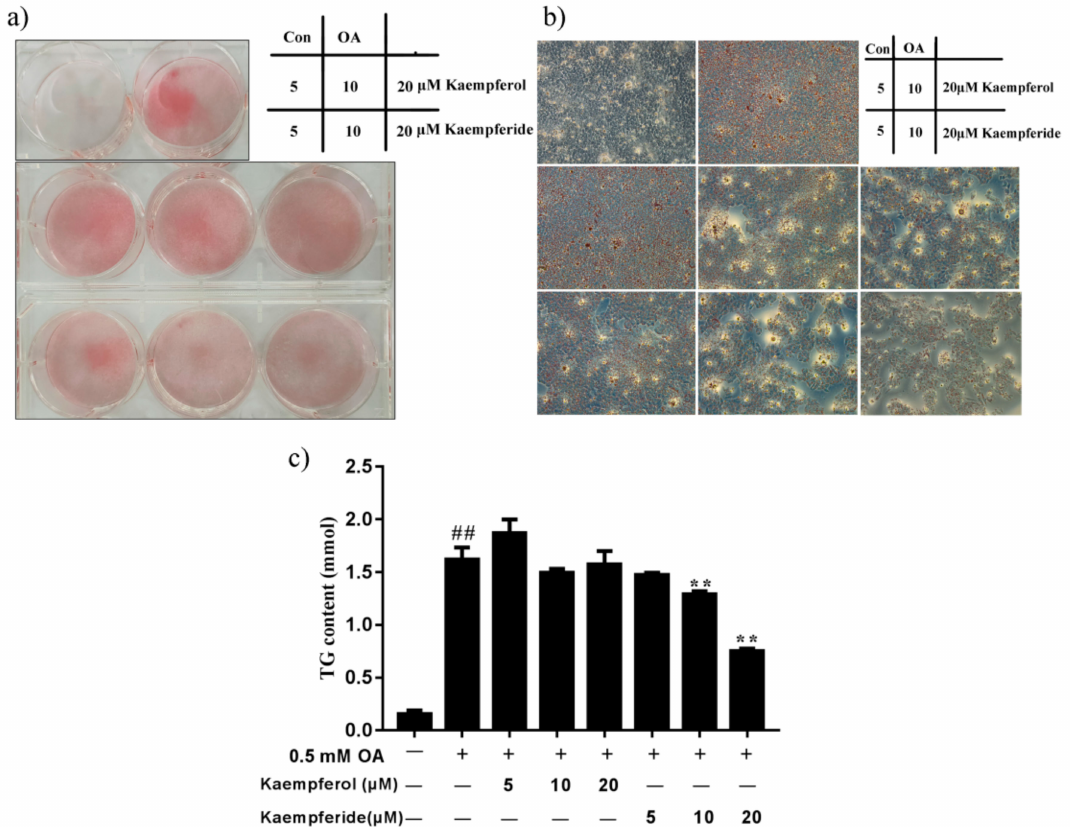
Figure 4. Kaempferol and kaempferide suppressed lipid accumulation in OA-induced HepG2 cells. HepG2 cells were incubated with different concentrations of kaempferol or kaempferide in the presence of 0.5 mM OA for 48 h. ( a ) Oil red O staining in the cultured HepG2 cells. ( b ) Visualization of intracellular lipid droplets in HepG2 cells under microscope (100 × magnification). ( c ) Quantification of intracellular TG contents in HepG2 cells. Data were expressed as mean ± SD of three independent experiments ( n = 3). ## p < 0.01, compared with vehicle-treated control cells (Con); ** p < 0.01, compared with OA-treated cells